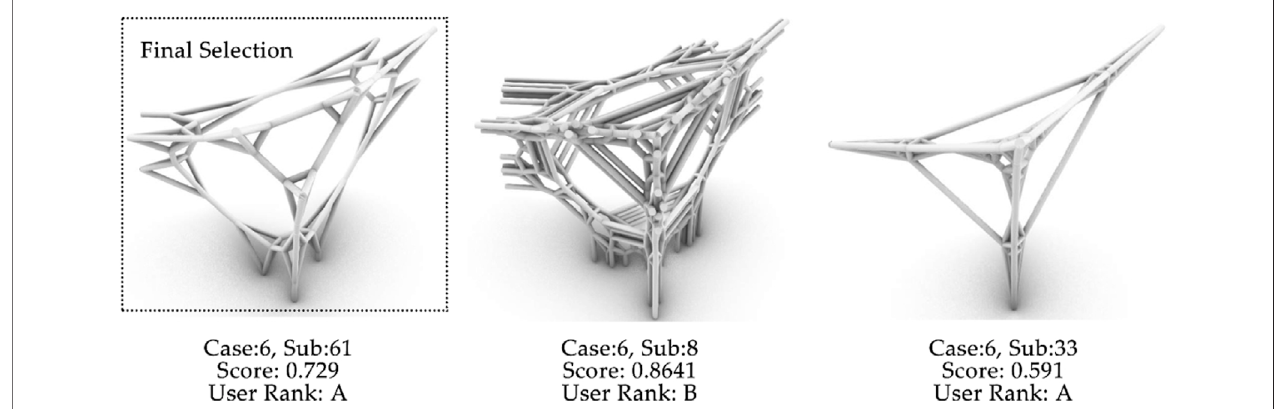
FIGURE 5 | Selection of form-found structures considering user taste by Zheng